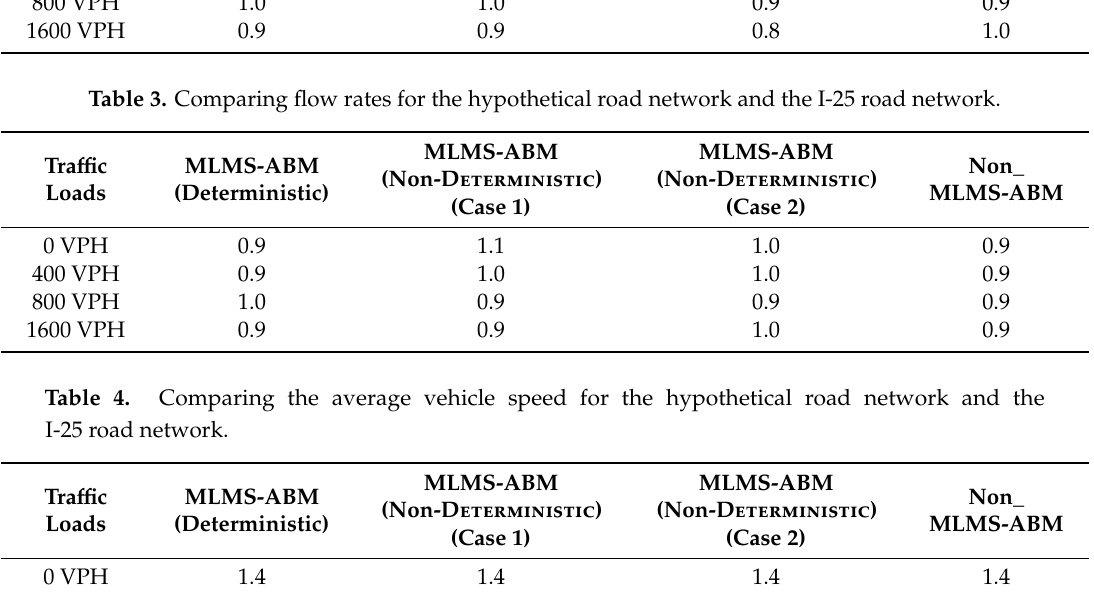
Table 4. Comparing the average vehicle speed for the hypothetical road network and the I-25 road network.